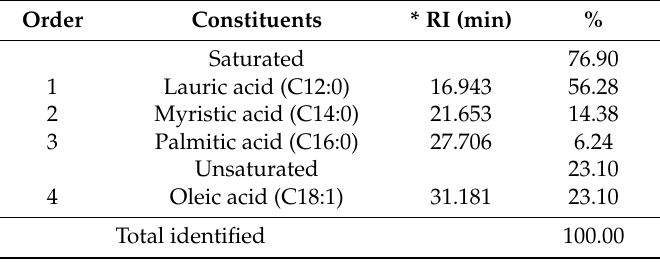
Table 3. Fatty acids identified in the fixed oil of the almond of O. speciosa